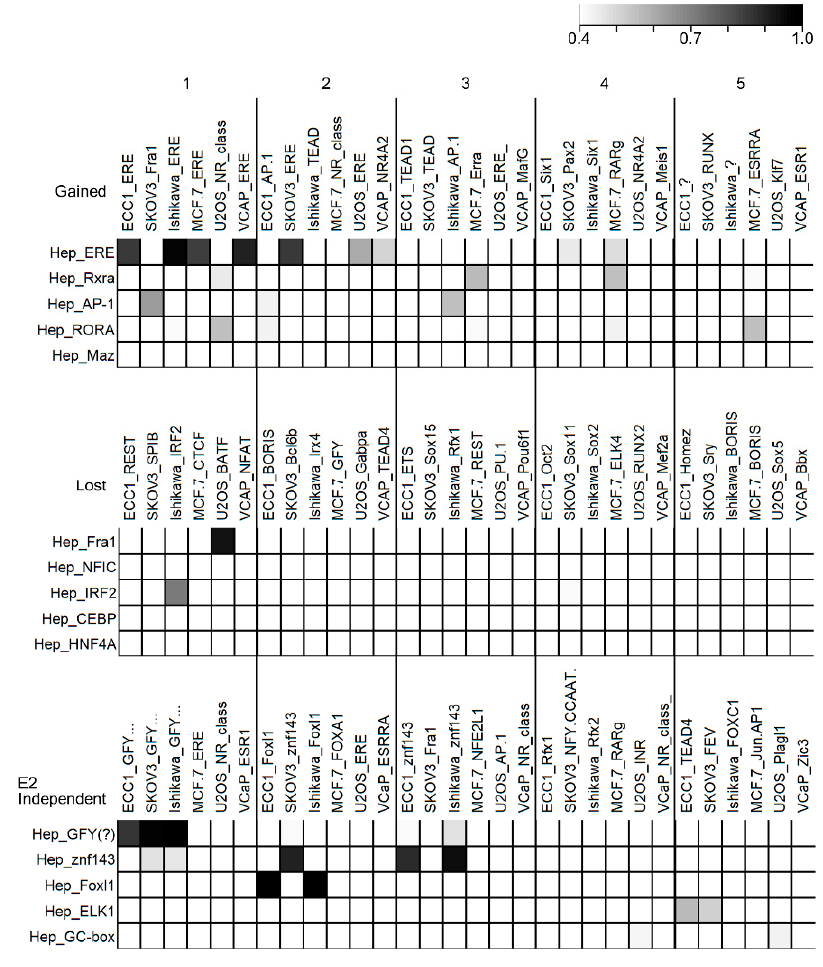
Figure 5. Comparison of enriched motifs identified for ligand-responsive and ligand-independent ESR1 peaks in various cell lines. Rows and columns are named with the cell type followed by the motif name (unknown motifs are labeled as “?”). Comparison matrices are separated by the ESR1 binding category (Gained, Lost, and E2 independent). Within each matrix, motifs from each cell line are compared to the top five motifs identified in the liver cells (row names, left). Each group is further divided into descending subgroups (left to right), with subgroup 1 being the #1 most enriched motif for the other six cell lines (column names) and subgroup five is the fifth most enriched motif (indicated by the numbers at the top of the figure). Darker cells indicate more similar motifs, ranging from identical (1) to not similar (0.4 or less), shown at the top right of the figure. Hep, hepatocytes.